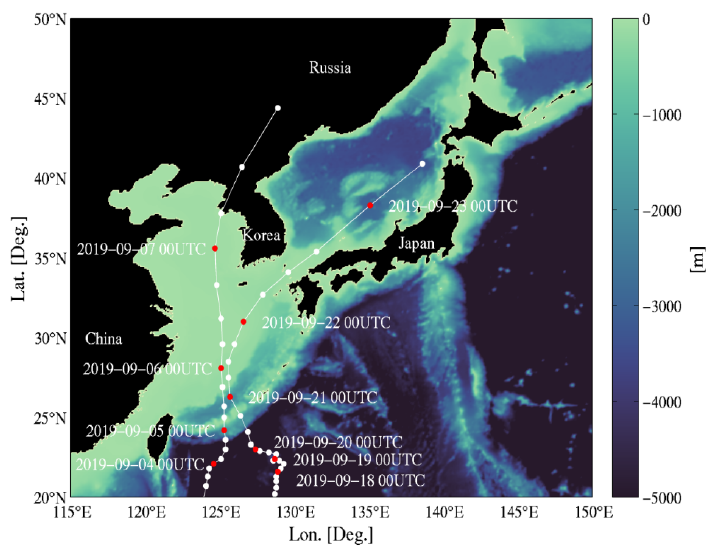
Figure 2. Best tracks of Lingling (2–8 September 2019) and Tapah (19–23 September 2019) provided by the Joint Typhoon Warning Center (JTWC).